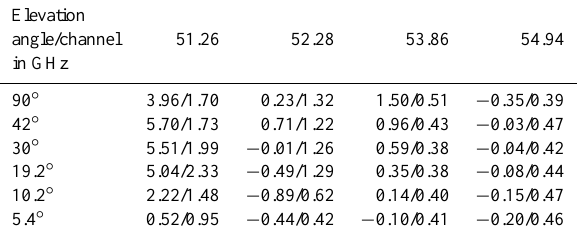
Fig. 3. TB offset time series at 90 ◦ elevation for 6 HATPRO V-band channels: TB(measured by MWR)-TB(simulated from sonde). The thick Figure 3 : TB offset time series at 90° elevation for 6 HATPRO V-band channels: TB(measured by 621 vertical lines indicate the absolute calibration times with liquid nitrogen. MWR)-TB(simulated from sonde). The thick vertical lines indicate the absolute calibration times with 622 Table 3. Clear sky offsets (MWR – simulated from sonde) and their standard deviations (both in K) for the MWR elevation angles and optically thin V-band frequency channels during the period between the fourth and fifth LN 2 calibration (268